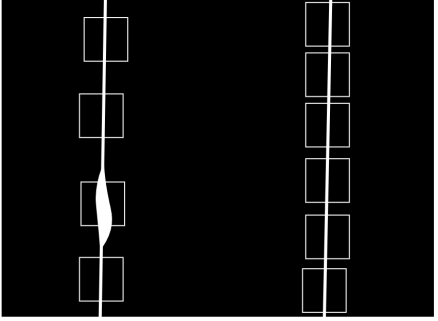
Figure 5. Excessive false detections by Model A, in a yarn image of the validation dataset (Adapted from [10]).